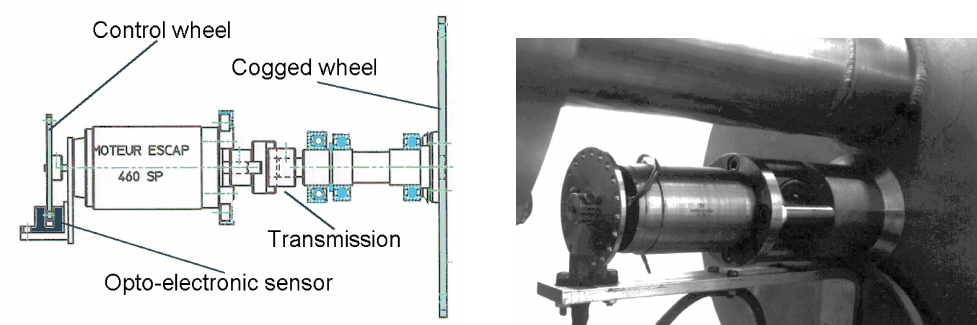
Figure 3. Optoelectronic sensor for real-time frequency and phase information on the air pulse state. ( Left ): Technical drawing. ( Right ): Close-up of the device mounted at the rear of the air pulsator carter.